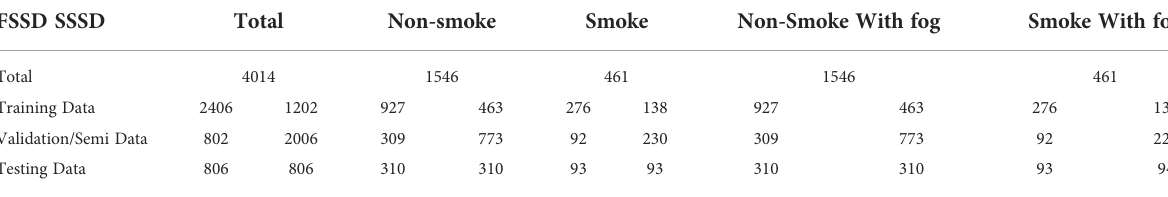
TABLE 1 Overall statistics of training, validation, and testing data for the proposed system. FSSD